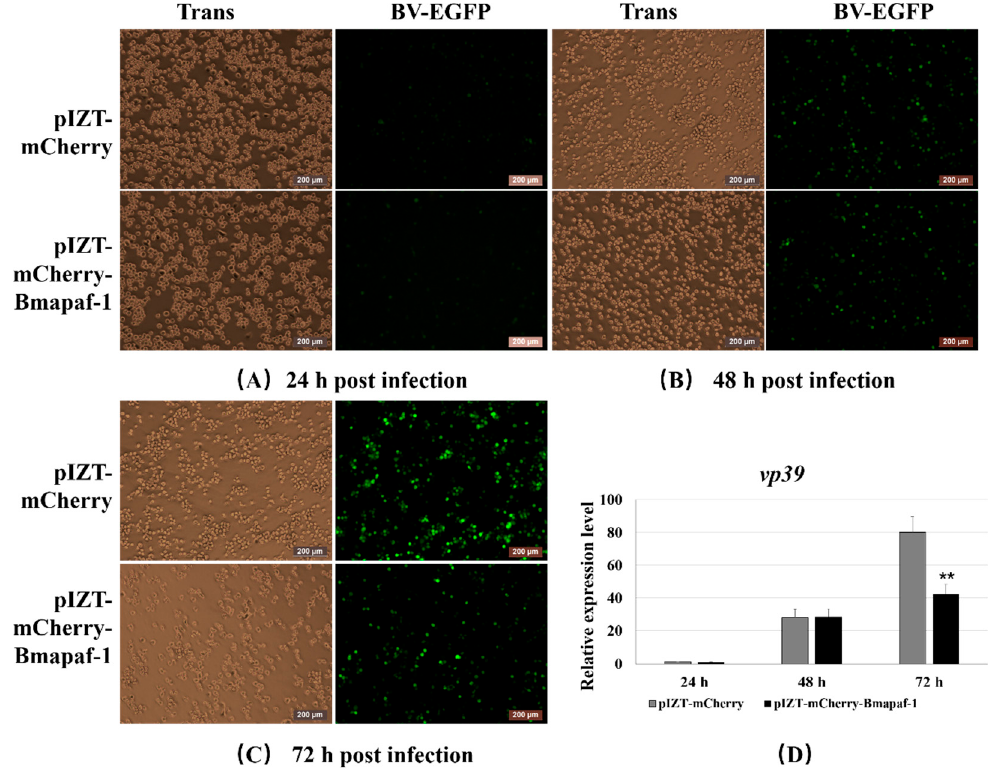
Figure 6. Analysis of BmNPV infection after overexpression of Bmapaf-1 at different times in BmN cells, 24 h ( A ), 48 h ( B ), and 72 h ( C ), after BV-EGFP infection. ( D ) The analysis of vp39 expression after overexpression of Bmapaf-1 at different times. Scale bar = 200 μ m. Trans (white), optical transmission. EGFP (green), expressed following the replication of BV. BmGAPDH was used to normalize the data that were shown as the mean ± standard error, the mean was from three independent repeats. The 2 − △△ Ct method was adopted to calculate the relative expression level. Differences among triple repeats were analyzed using the SPSS Statistics 20 software (IBM, USA) with the one-way ANOVA method. Asterisks represent the significant difference, as follows: ** p < 0.01.